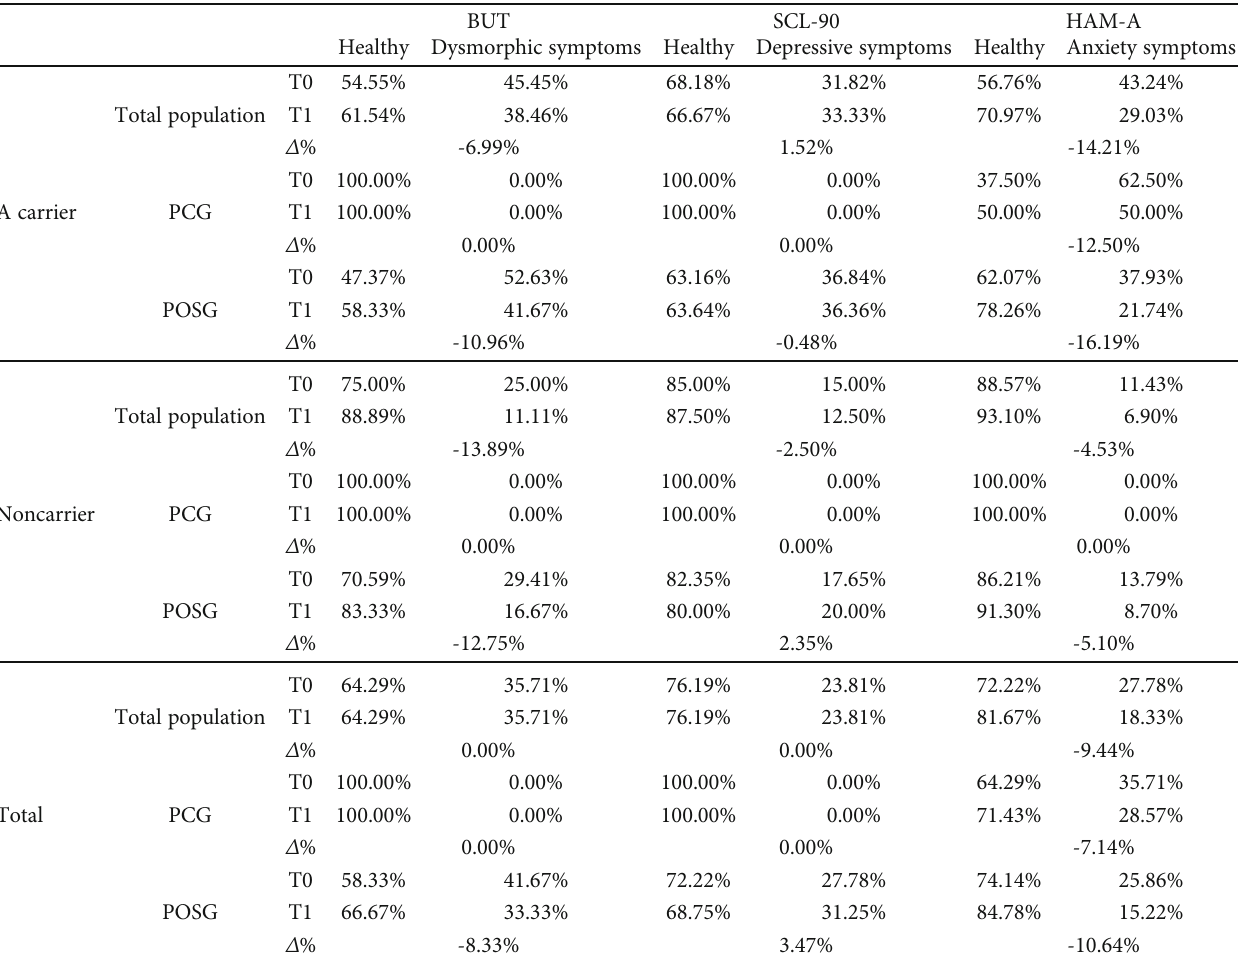
Table 5: BUT, SLC-90R, and HAM-A frequencies.